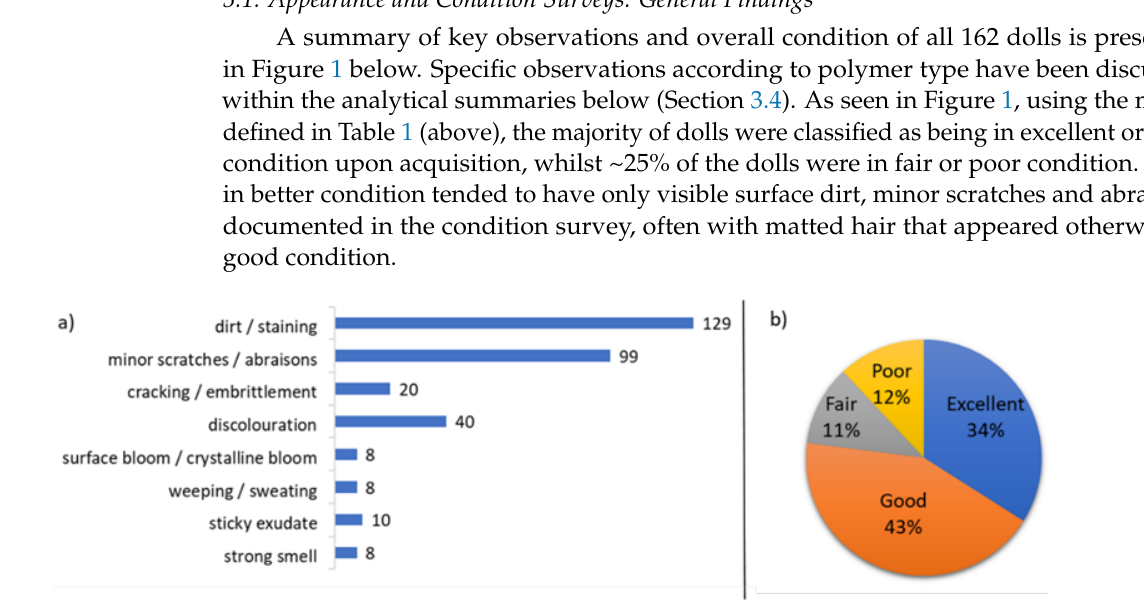
Figure 1. ( a ) Distribution of key observations from the condition survey of all 162 dolls in Zoe Leonard’s Mouth Open, Teeth Showing 2000. The numbers of dolls presenting the specified observations were recorded to gain an insight into common and less common ageing and degradation phenomena. ( b ) Summary of the proportion of all 162 dolls classed as being in excellent, good, fair and poor condition according to the condition metric defined in Table 1. All observations were recorded in 2019.